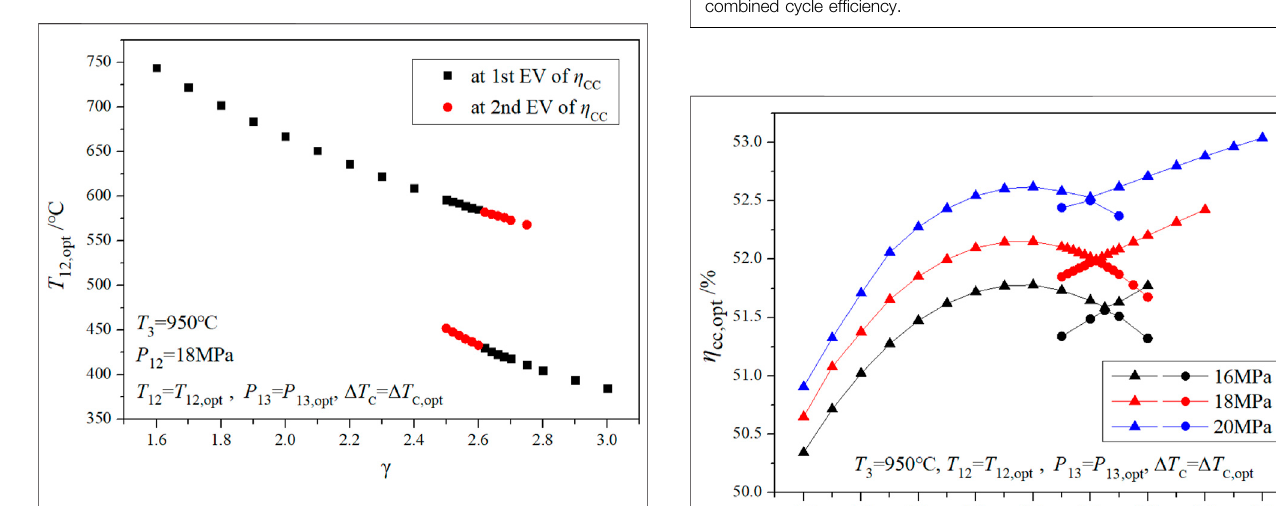
FIGURE 9 | Main steam temperatures corresponding to the extreme values of combined cycle ef fi ciency.